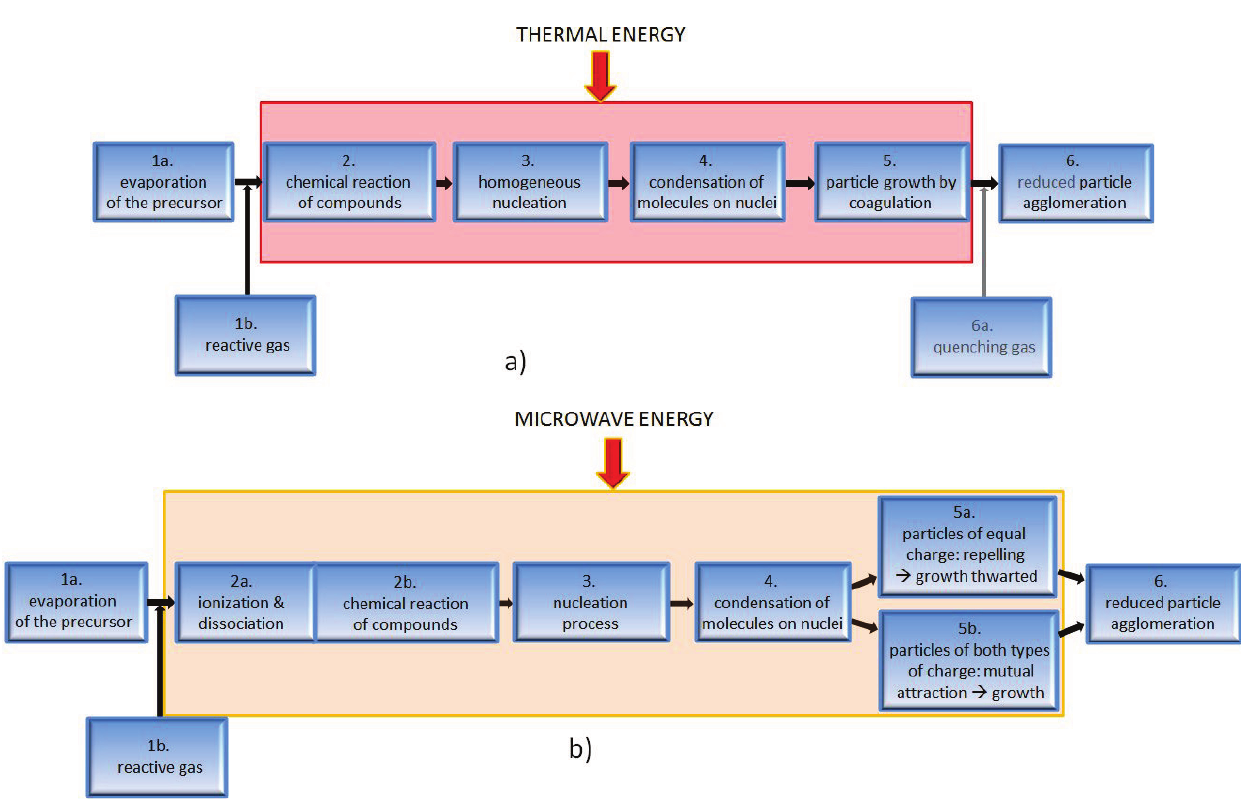
Figure 4. Visualization of the general steps of particle formation occurring in gas phase reactions. Thermally supported gas-phase reactions with optional quenching step ( a ). Microwave plasma generated gas-phase reactions ( b